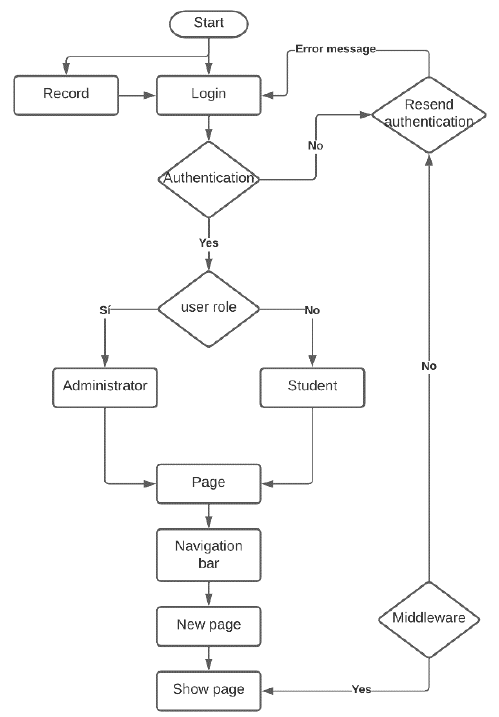
Figure 2. Block diagram of the application.